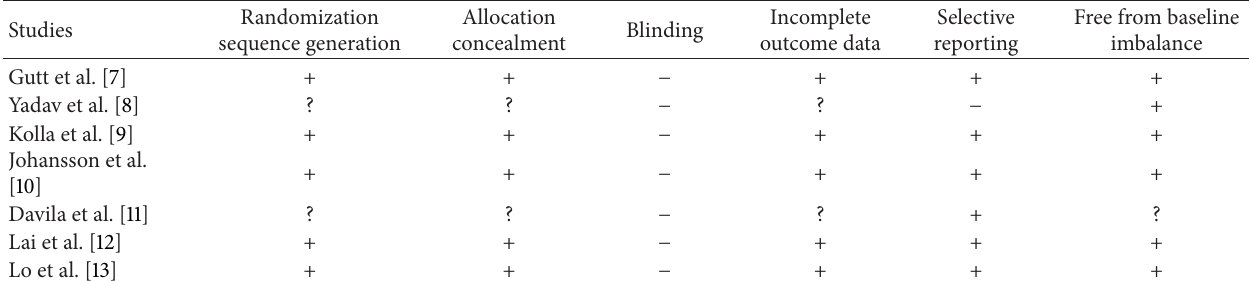
Table 2: Risks of bias in included